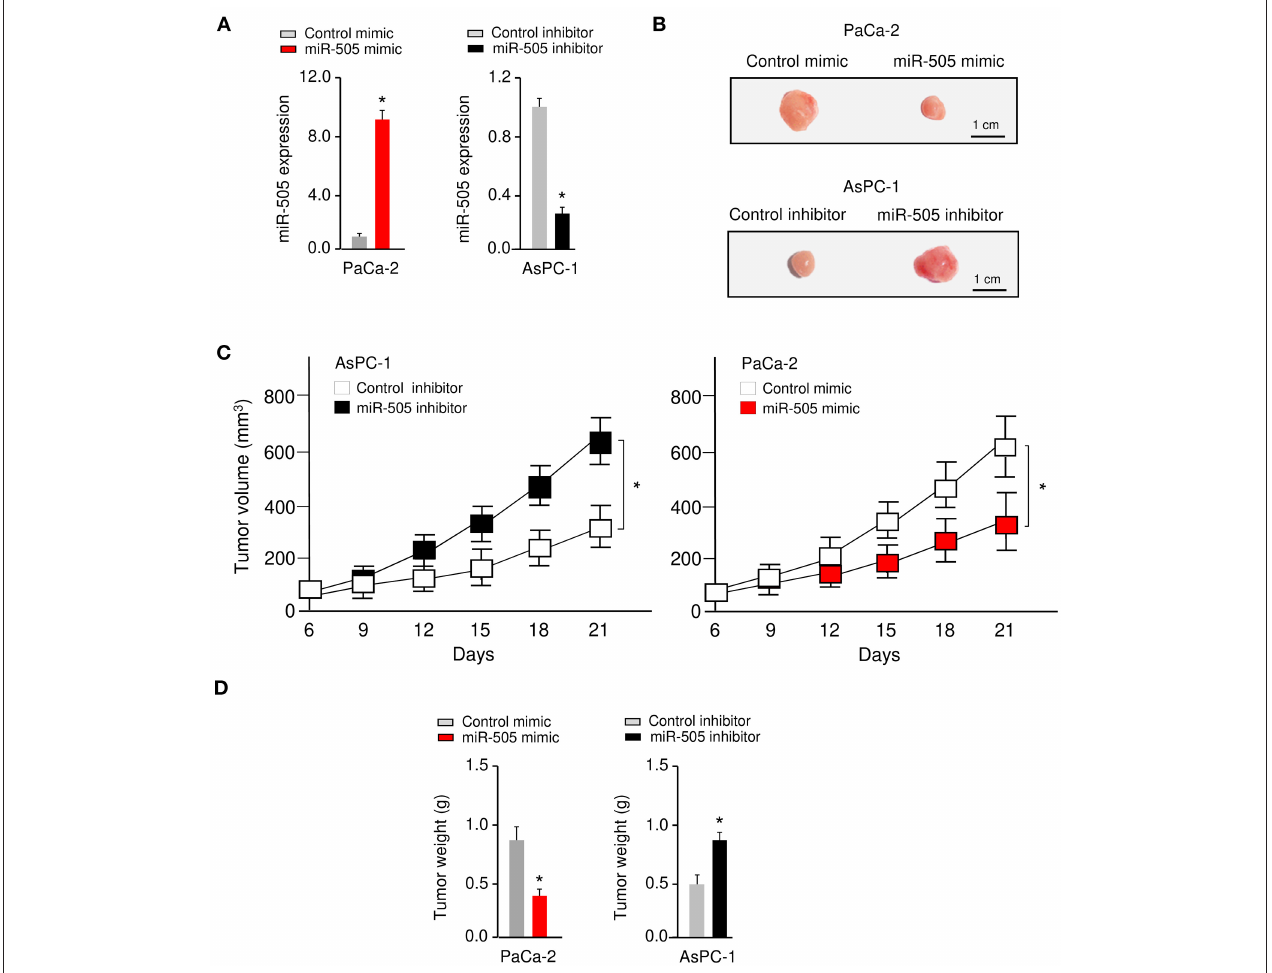
FIGURE 3 | miR-505 represses tumorigenesis of PC cells in vivo. (A) The levels of miR-505 in PC cells transfected with miR-505 mimic, miR-505 inhibitor or their negative controls, respectively. (B–D) Nude mouse xenograft model s were established by subcutaneously implanting PaCa-2 cells transfected with (or without) miR-505 mimic, or AsPC-1 cells transfected with (or without) miR-505 inhibitor, respectively. Representative images (B) , tumor volume growth curves (C) , and weight (D) of the formed tumors. Scale bar: 1cm. * P <